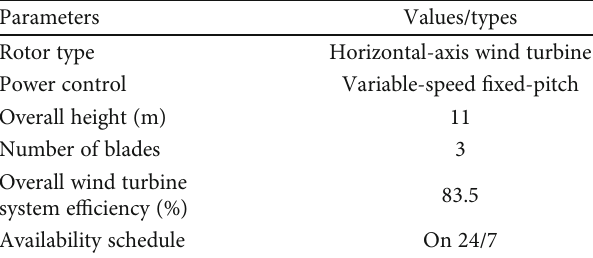
Table 3: Wind turbine speci fi